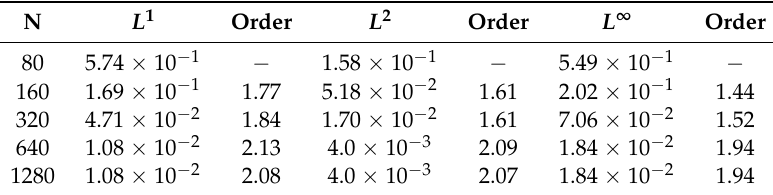
Table 3. Relative errors of the scheme (9)/(10)/(11).